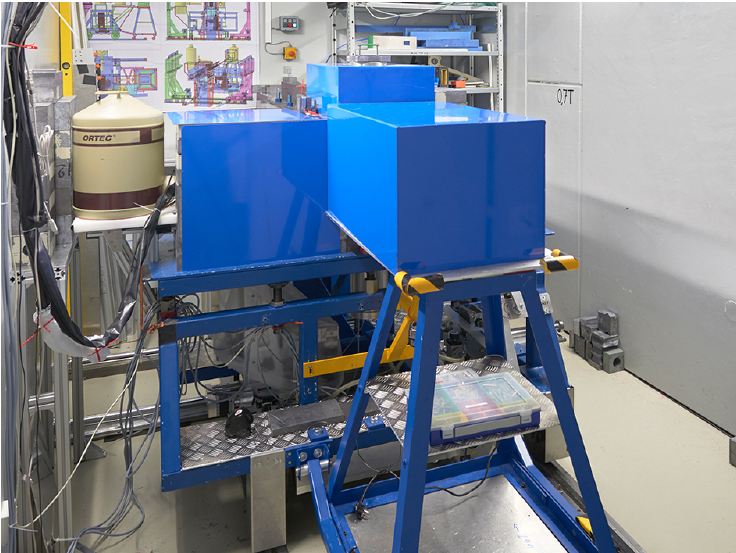
Figure 1: Instrument PGAA from the direction of the beam stop. On the left-hand side the Dewar of the detector can be seen. (Copyright by W. Schürmann,